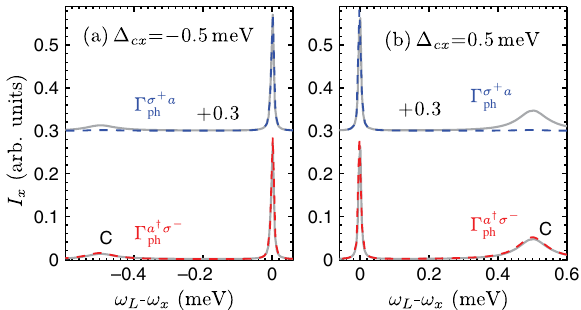
FIG. 4. (a)Influenceoftheroleoftheeffectivephonon-scattering (reddashedline)and (cid:3) (cid:1) þ a (bluedashedline),onthePL rates, (cid:3) a y (cid:1) (cid:1) ph ph ¼ for a cavity-driven system at T ¼ 4 K for (cid:1) intensity I x cx (cid:1) 0 : 5 meV . Also shown is the full polaron ME solution (grey lines) curves are shifted vertically by 0.3, [Eq. (11)]. For clarity, the (cid:3) (cid:1) þ a ph along with the fullpolaron ME solution. We plot the contribution of one effective Lindblad rate per calculation. (b) As in (a) but for ¼ 0 : 5 meV . The parameters are the same as in Fig. 3, but with (cid:1) cx ¼ 40 (cid:8) eV (cavity pumping). Since we have cavity excitation, (cid:4) c are then the phonon-scattering rates (cid:1) (cid:1) þ =(cid:1) (cid:1) ph